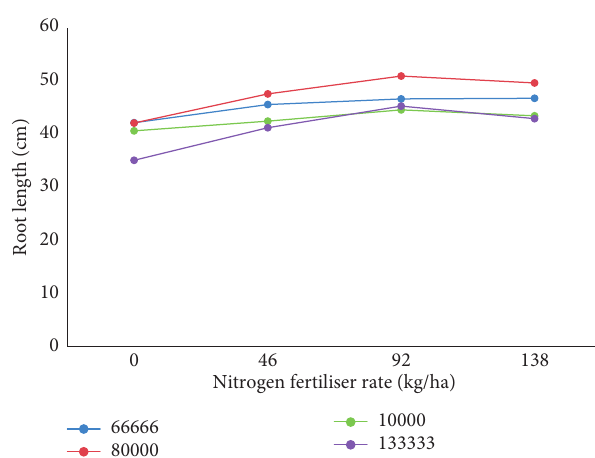
Figure 2: Interaction effects of plant density and nitrogen fertilizer rates on root length (cm) of